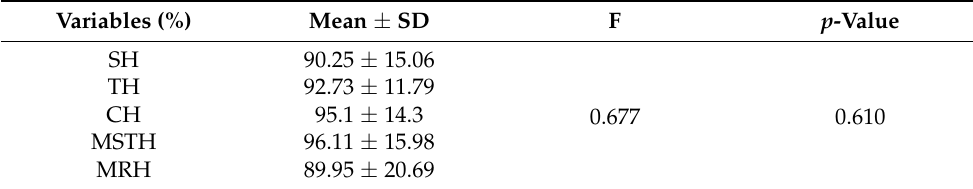
Table 4. Differences in the limb symmetry index